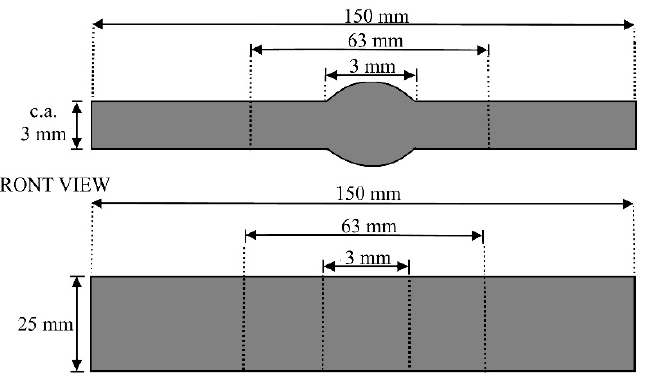
Figure 1. Drawing of specimens for tensile tests. Welding length: 3 mm; gauge length: 60 + weld length; thickness: ca. 3 mm; width: 25 mm; total length 150 mm.